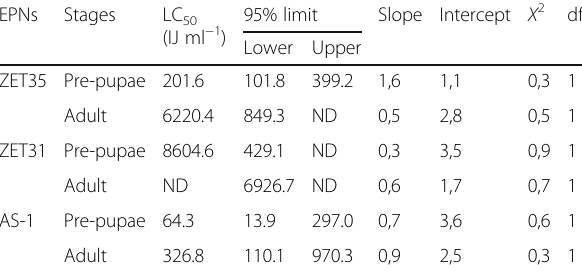
Table 1 Calculated LC 50 values for pre-pupae and adults of A. alni treated with three EPN isolates, Heterorhabditis